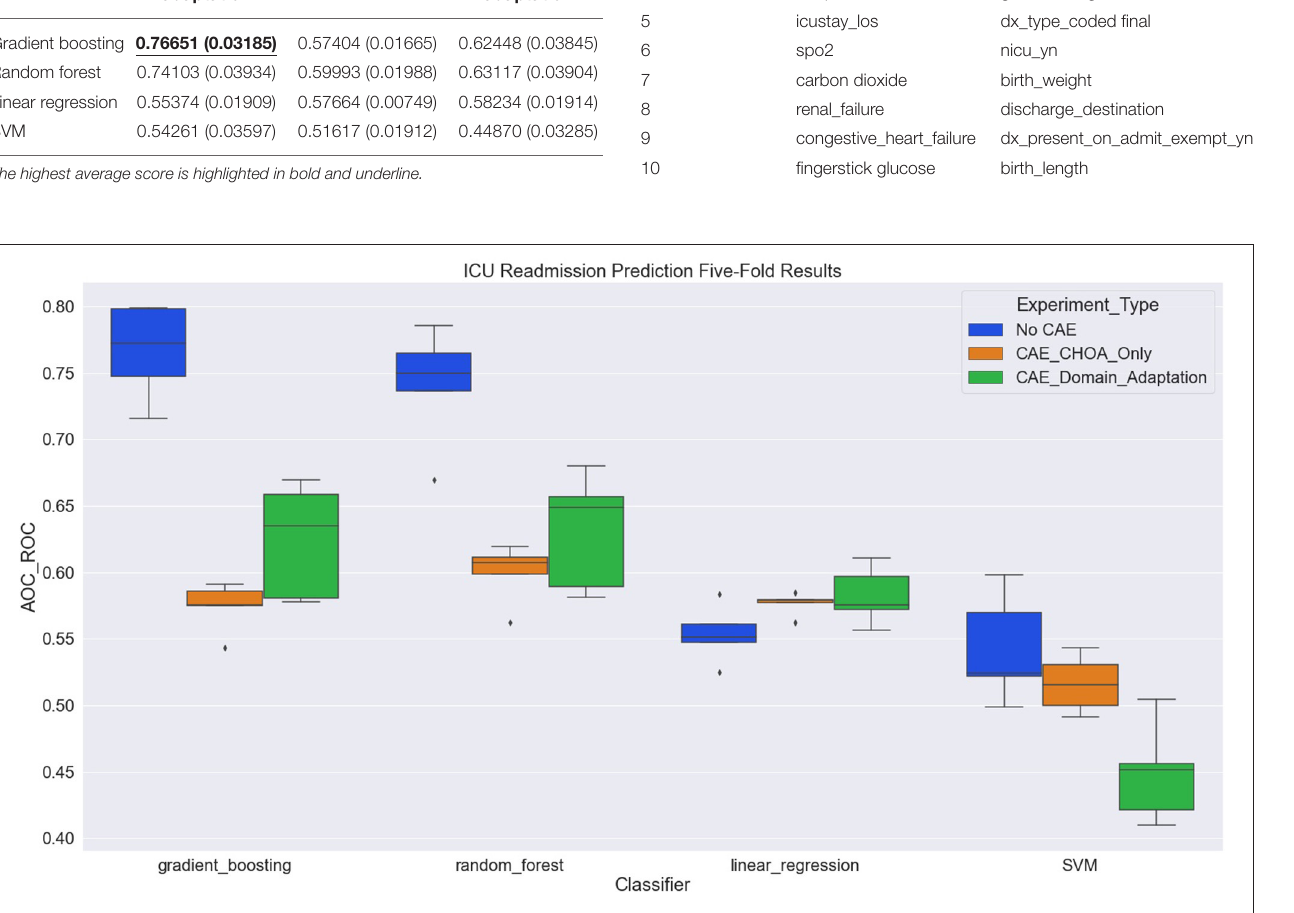
FIGURE 4 | Boxplot of intensive care unit (ICU) readmission prediction results using four different classifiers with three experiment settings.